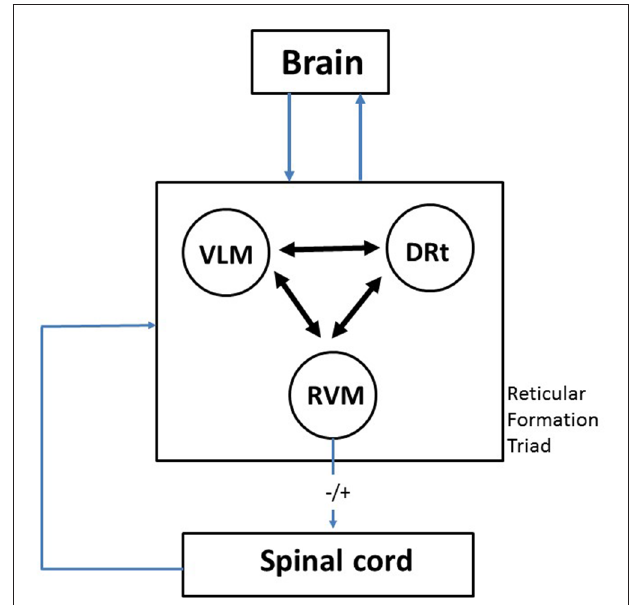
FIGURE 1 | Diagram depicting the crucial role of the medullary reticular formation (RF) triad rostroventromedial medulla (RVM)-ventrolateral medulla (VLM)-dorsal reticular nucleus (DRt) as a gateway between the brain and the spinal cord. The three components of the triumvirate are reciprocally connected in a way which allows integration of responses which are related to pain, namely cardiovascular control and motor reactions. This probably represents a phylogenetically conserved mechanism that subserves the classical “fight or flight” response, activated by acute pain. The emotional and cognitive control exerted by higher brain centers upon the RVM-VLM-DRt triad may account to explain how the emotions and attention affect pain responses. By allowing to balance inhibition and facilitation ( − /+) of nociceptive transmission at the spinal cord, the RVM-VLM-DRt medullary triad provides the mechanism to decrease or increase pain. A more detailed description of the neuronal circuits involving one component of the triad—the DRt—is shown in Figure 2 , namely in what concerns its brain connections and their neurochemical